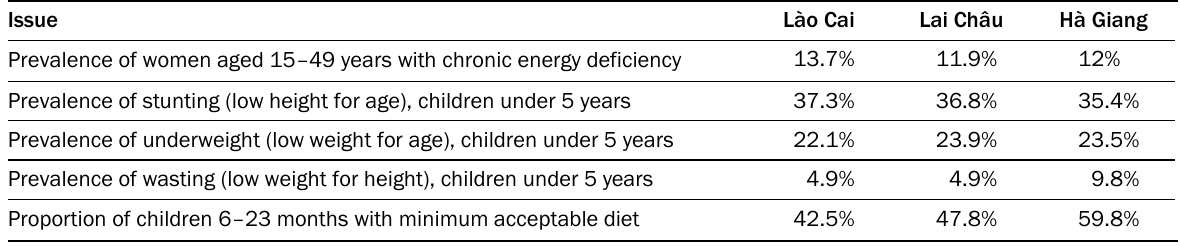
Table 1. Nutrition Profile of Provinces in the Northern Mountainous Region of Vietnam,